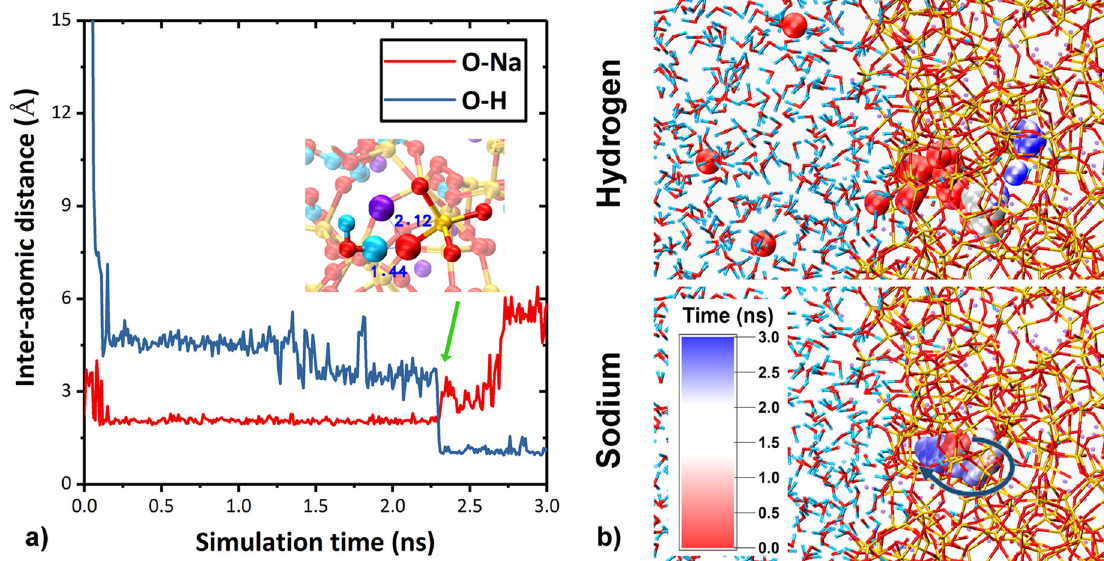
Fig. 2 Bond distance evolution and trajectories during a Na + and H + ion-exchange process. a Evolution of O – Na and O – H distances on an ion exchange site of silanol group as a function of time (at 450 K) and zoomed in snapshot shows the two distances among three big spheres (O, H, and Na in red, cyan, and purple, respectively). The cross of bond distances at 2.3 ns indicate when the ion-exchange reaction happened. b The proton (top) and sodium (bottom) transport trajectories: the big spheres stand for the positions of the selected H + /Na + ions during the reactions with a background snapshot of fi nal con fi guration. The spheres are colored by the simulation time, where the red color is near the beginning of the reactions (~0 ns) and the blue ones are near the end (~3.0 ns), respectively. It shows that the hydrogen atom diffuses from bulk water (top) while the sodium ion slowly diffuses toward the glass – water interface (bottom).